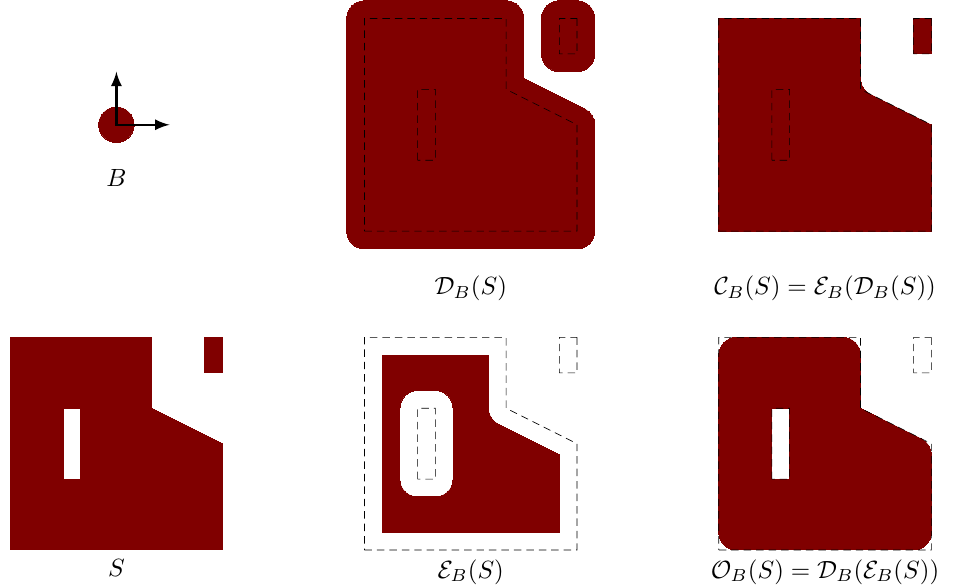
Figure 2. The four basic morphological operators defined by the ball B acting on the set S